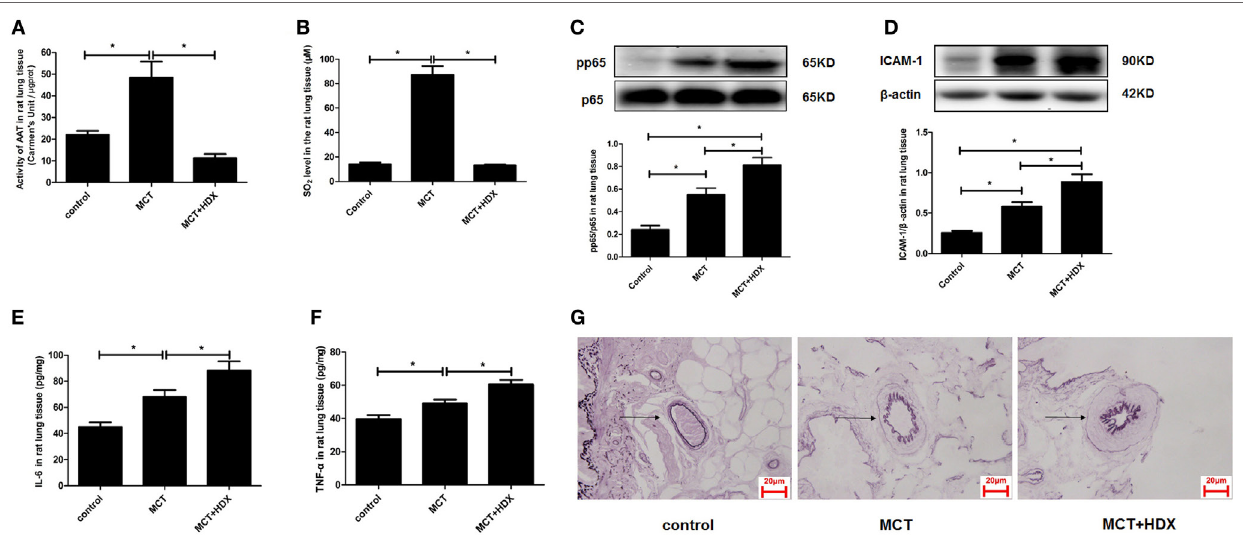
FigUre 9 | Upregulation of endogenous SO 2 production exerted compensatory effects to inhibit pulmonary vascular inflammation caused by downregulated H 2 S/ cystathionine γ -lyase (CSE) pathway in vivo . (a) Aspartate aminotransferase (AAT) activity in the rat lung tissues detected by colorimetry assay. (B) The SO 2 level in the rat lung tissues detected by high-performance liquid chromatography assay. (c) The ratio of pp65/p65 in the rat lung tissues detected by western blotting. (D) The expression of ICAM-1 in the rat lung tissues detected by western blotting. (e,F) The level of IL-6 and TNF- α in the rat lung tissue detected by enzyme-linked immunosorbent assay. (g) The morphological change of small pulmonary arteries in the rats observed following the staining by the modified Weigert’s elastic fiber dye. The small pulmonary artery was indicated by dark arrow. The internal and external elastic lamina were shown as dark-purple color under microscope. * P < 0.05. Data are expressed as means ± SEM, n =